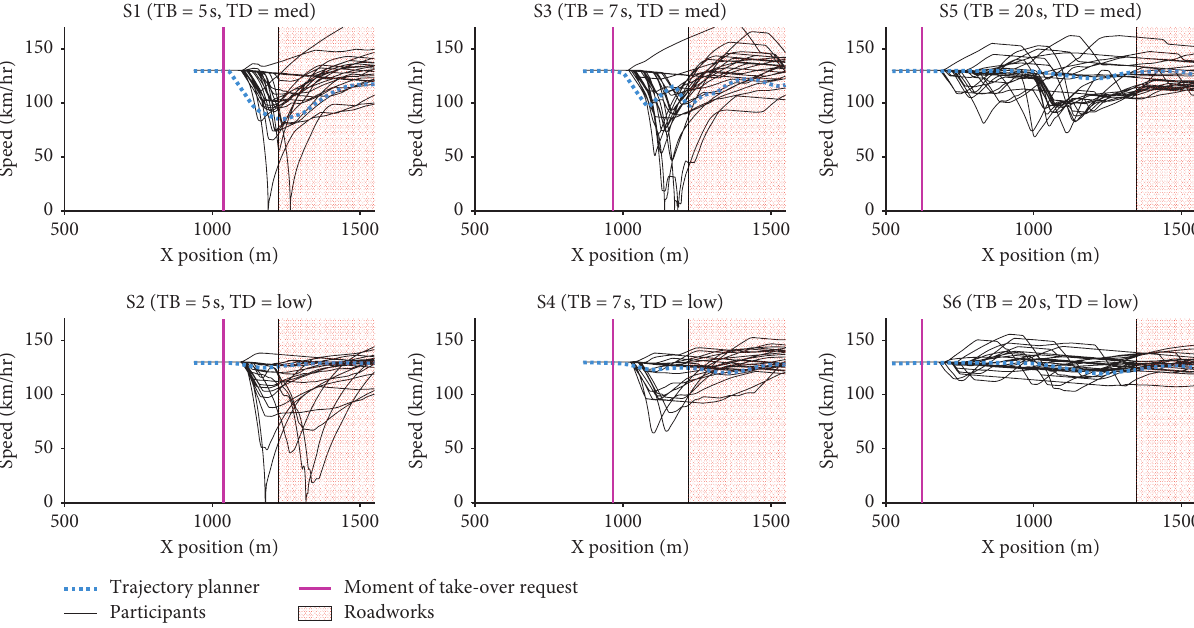
Figure 5: Speeds of all participants in the six scenarios, including the result for the trajectory